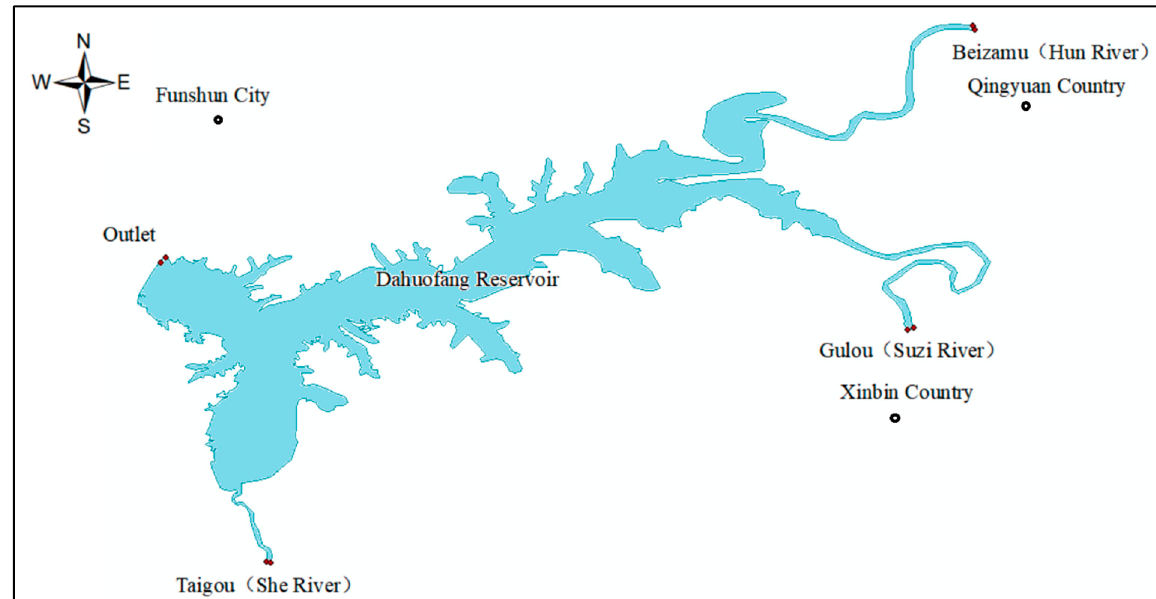
Figure 1. Location map of Dahuofang Reservoir and the upstream watershed.